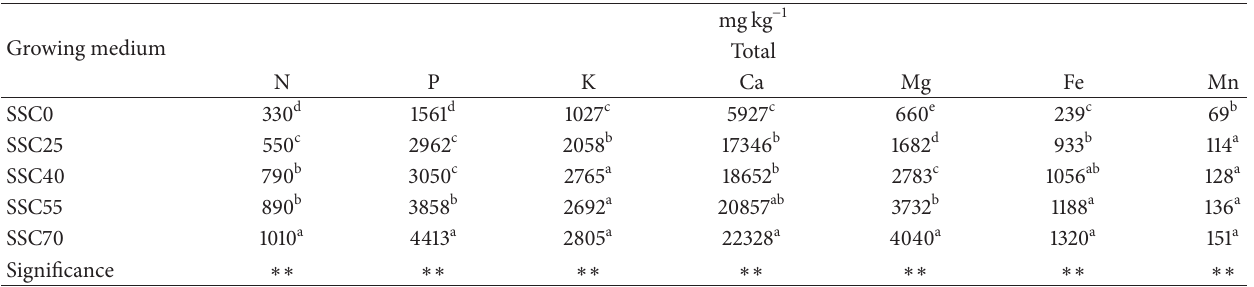
Table 5: Chemical characteristics of the growing media used (at transplant).